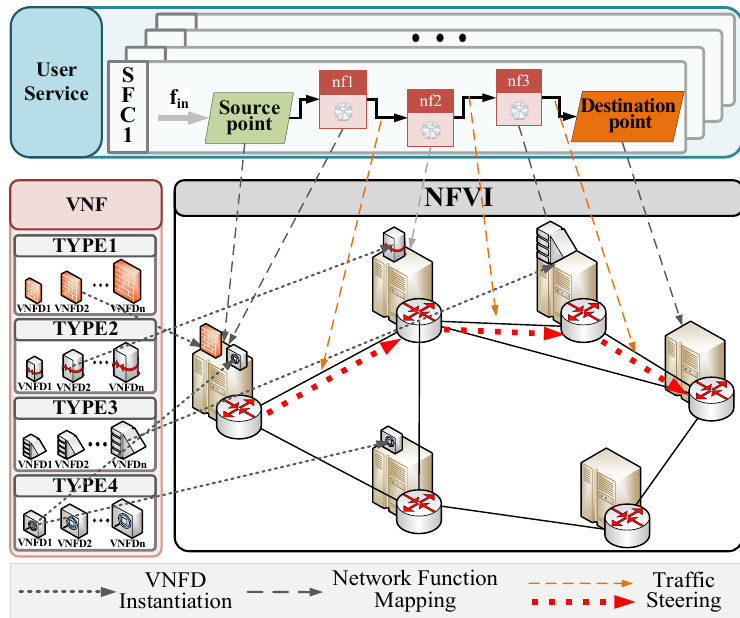
Figure 1. The overall system model of service function chain deployment.